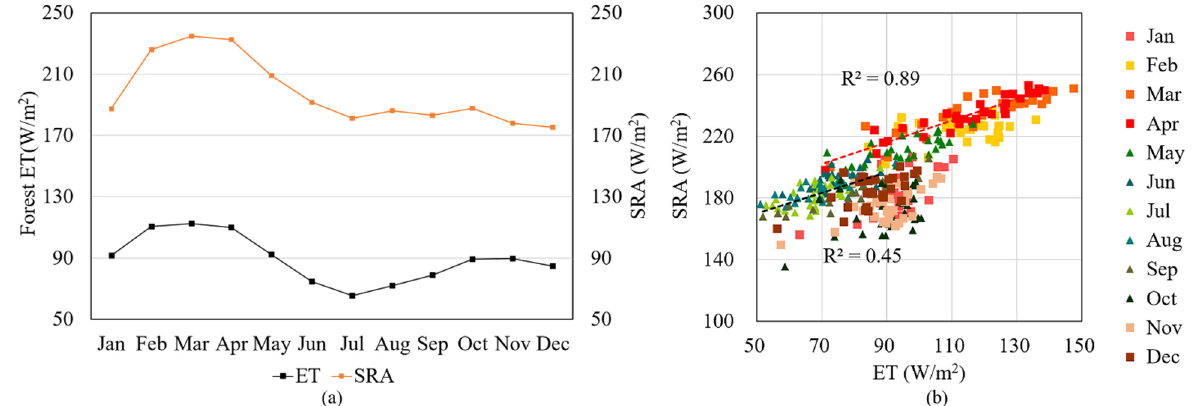
Figure 12. ( a ) Variation of monthly SRA and monthly ET in forest areas of the Lower Mekong River Basin in multiple years. ( b ) The effect of SRA on monthly ET in forest areas. Every 30 points in the figure represent the value of SRA and ET of a month, and the shape of those points have been divided into triangle and square to present rainy season and dry season, respectively.